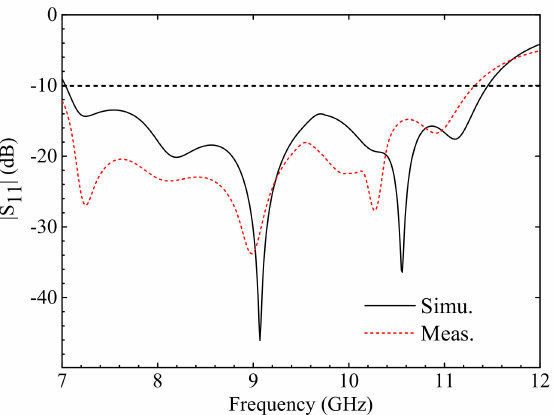
Figure 18. Measured and simulated | S 11 | of the proposed array with DGS, and frequency bands covering 7–11.2 GHz.